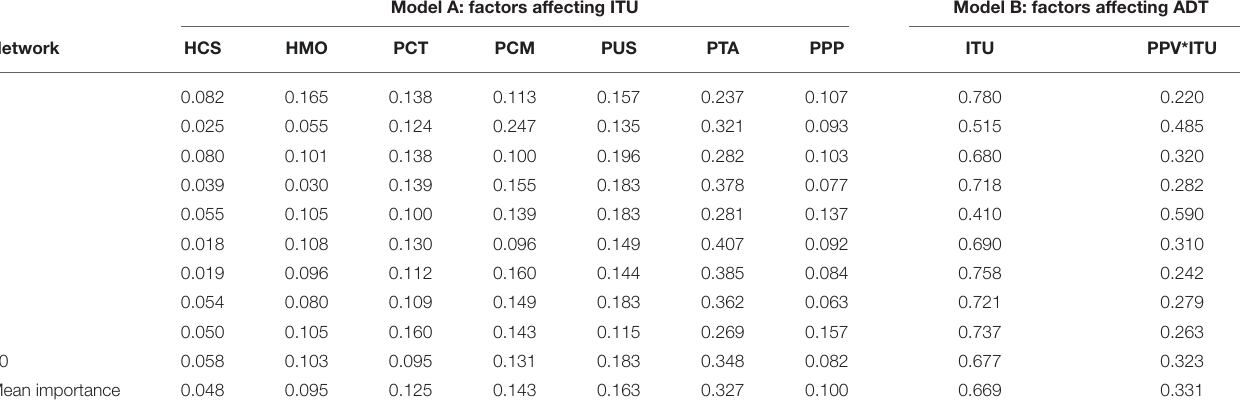
TABLE 8 | Sensitivity analysis. Model A: factors affecting ITU Model B: factors affecting